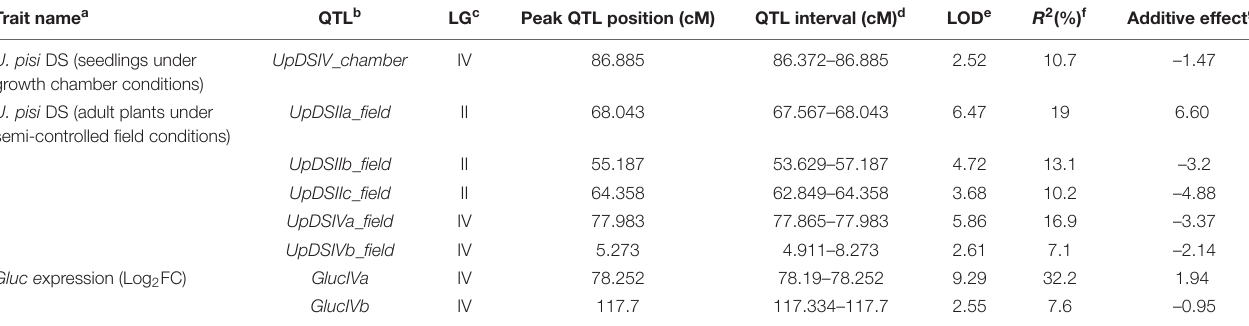
TABLE 3 | Phenotypic quantitative trait loci (pQTLs) and expression QTLs (eQTLs) identified for response against Uromyces pisi in the Lathyrus cicera RIL population (BGE023542 ×